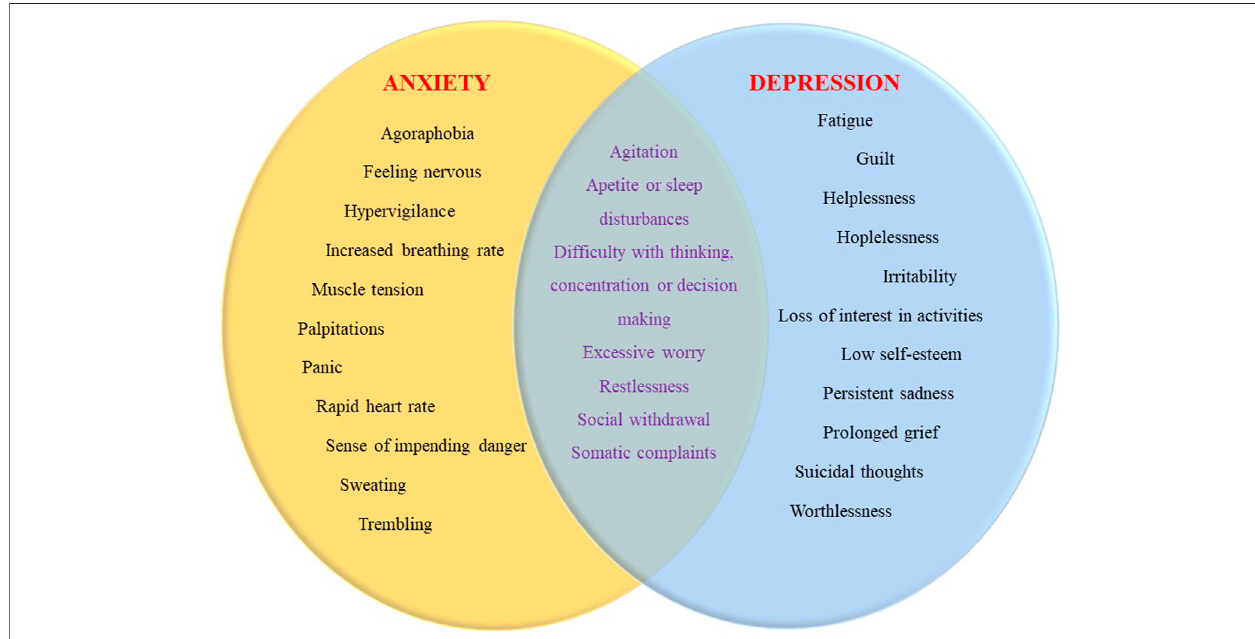
FIGURE 2 | Symptom overlap between anxiety and